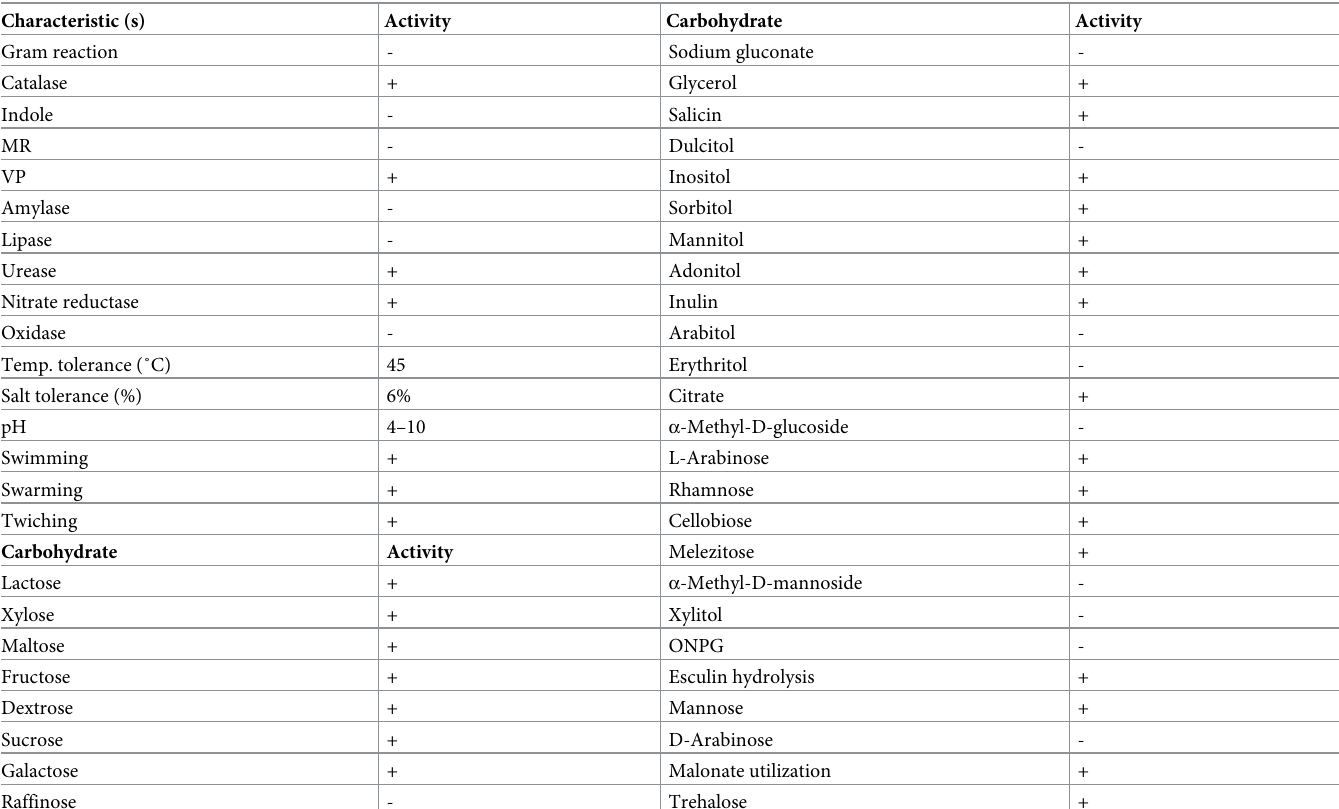
Table 2. Biochemical characteristic feature of